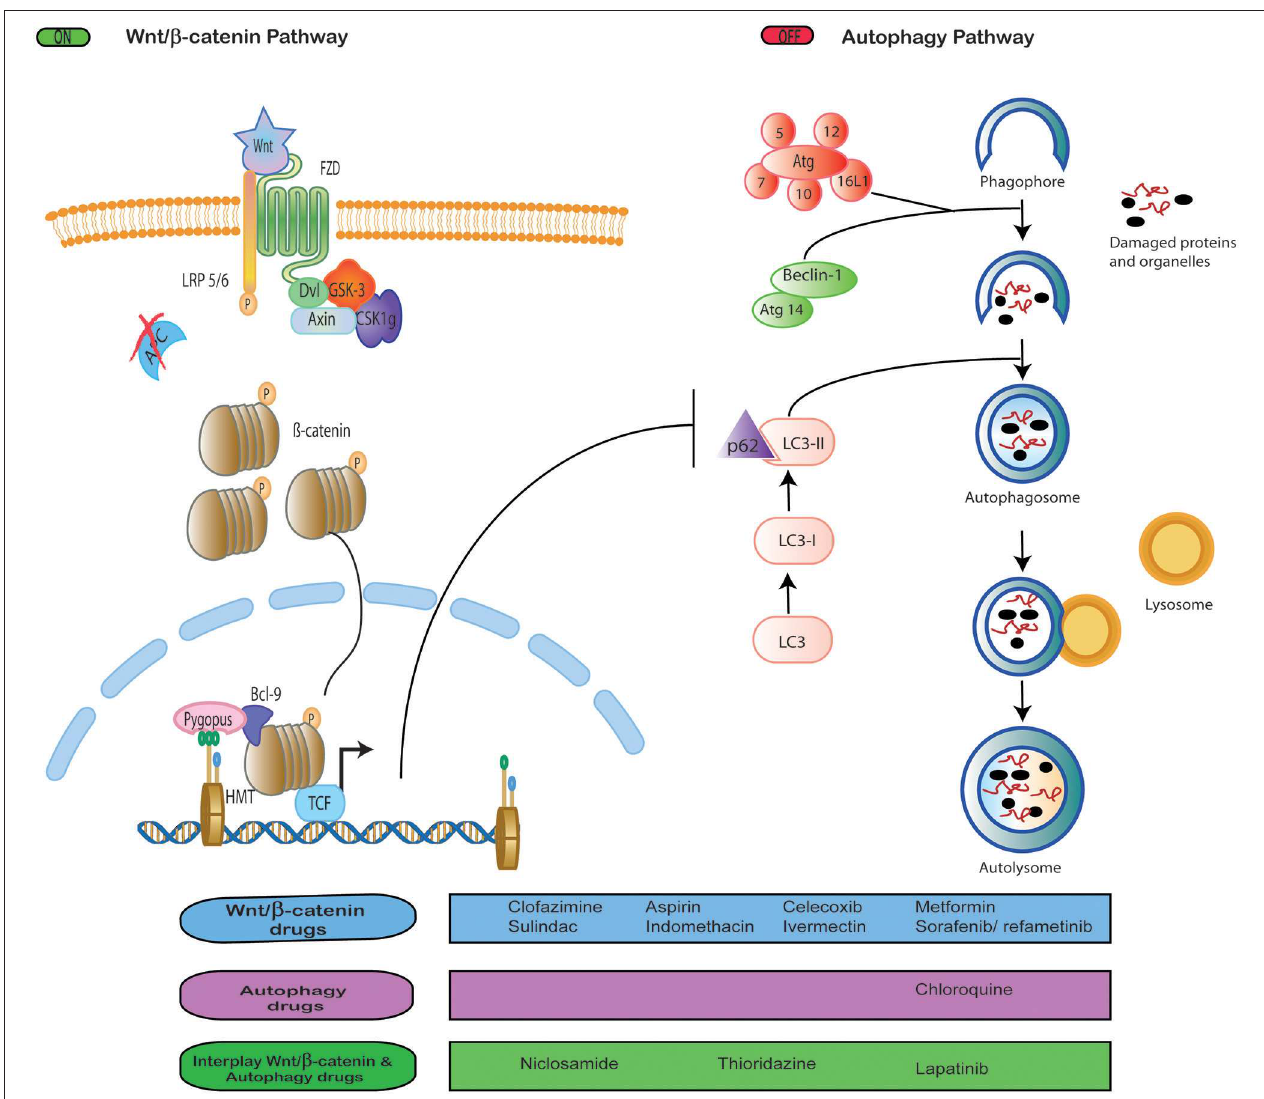
FIGURE 1 | Interplay between Wnt signaling and autophagy. Drug repositioning to block Wnt/ β -catenin signaling and autophagy, both independently and simultaneously.